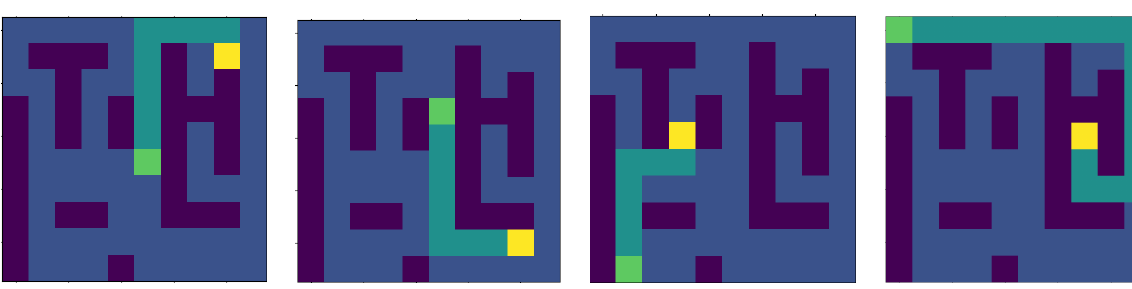
Figure 3: Solutions to the 2-link manipulator as shown in Figure 2. Regular states are blue, prohibited states are dark blue, the starting state is green, the goal yellow and the path turquoise. θ 1 and θ 2 are represented by row and column respectively.